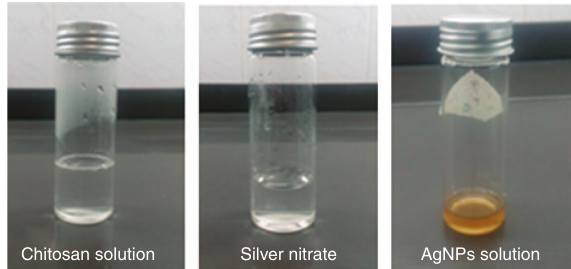
Figure 1: Color and appearance of the chitosan, silver nitrate and mixture solution containing silver nanoparticles